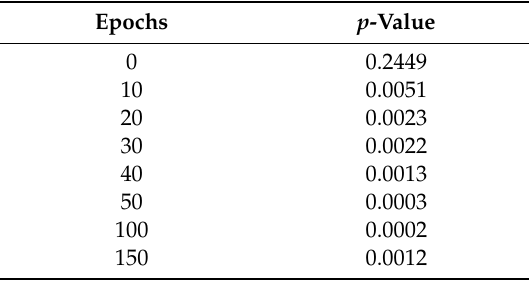
Table 5. The t-test